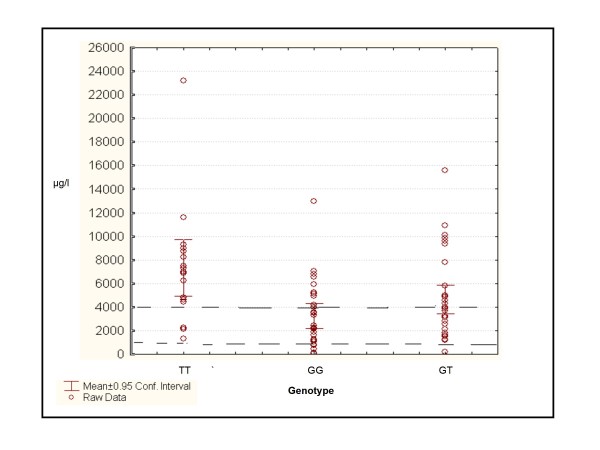
Dot plot of EFV plasma concentrations by CYP2B6-516 genotype. GG, homozygous wild-type; GT, heterozygous genotype, TT homozygous genotype. --Value between dashed lines represents therapeutic range.